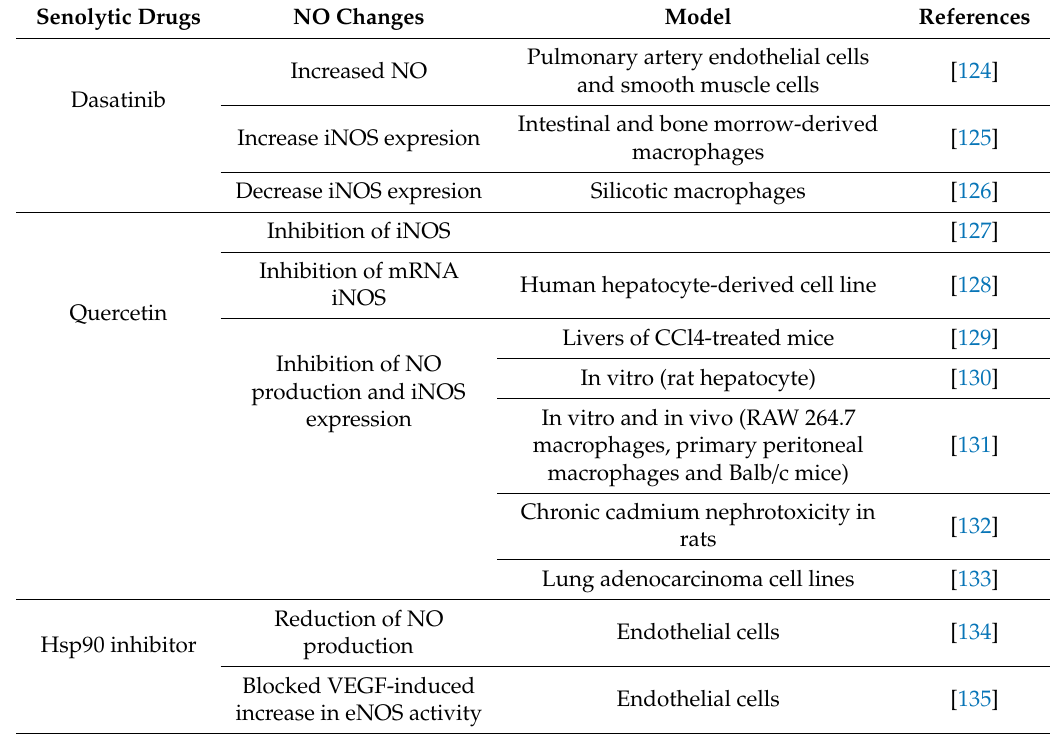
Table 2. Senolytic-induced nitric oxide (NO)